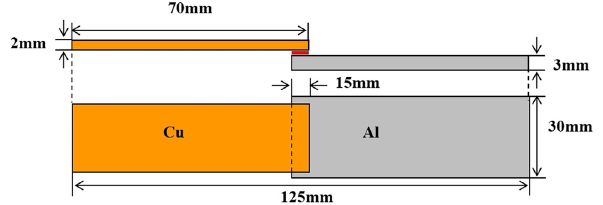
Figure 1: Model of the CU – Al brazing lap joint.